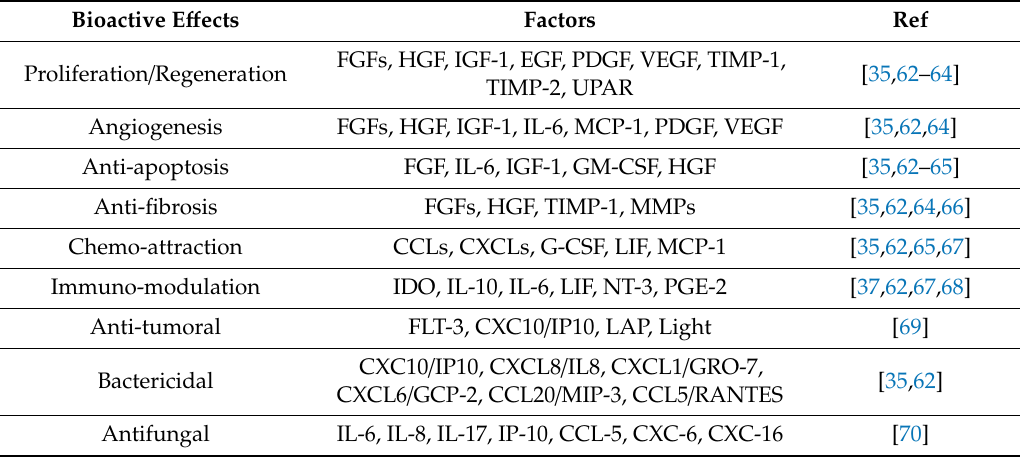
Table 3. Bioactive factors in MSC-derived secretome.